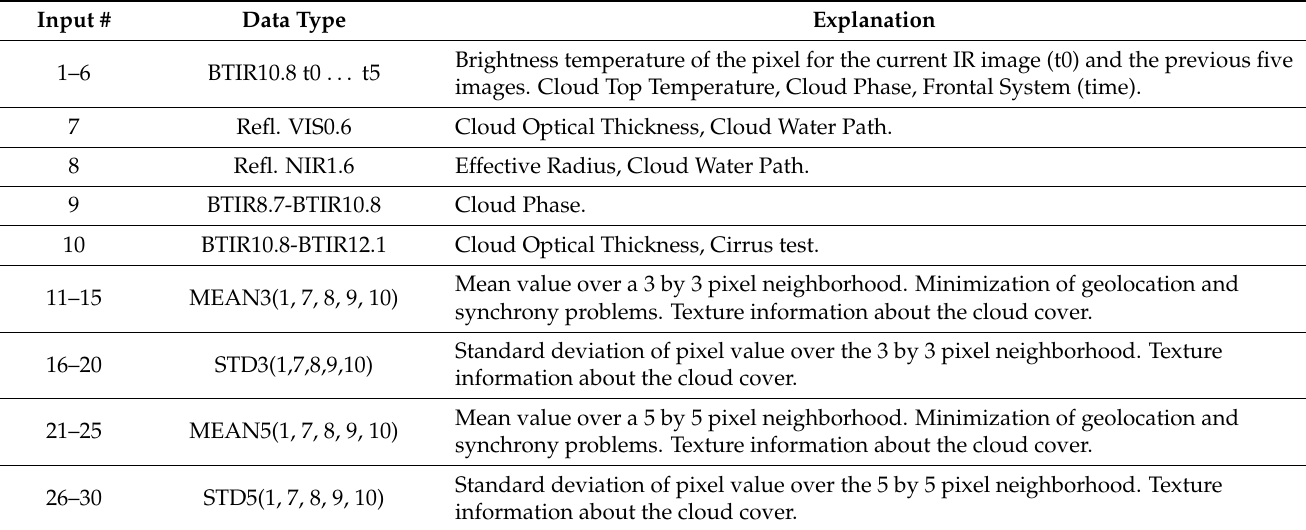
Figure 2. Part ( a ): processing chain to train NN1; part ( b ): processing chain to train NN2; part ( c ): operational flow chart. Table 3. Day time